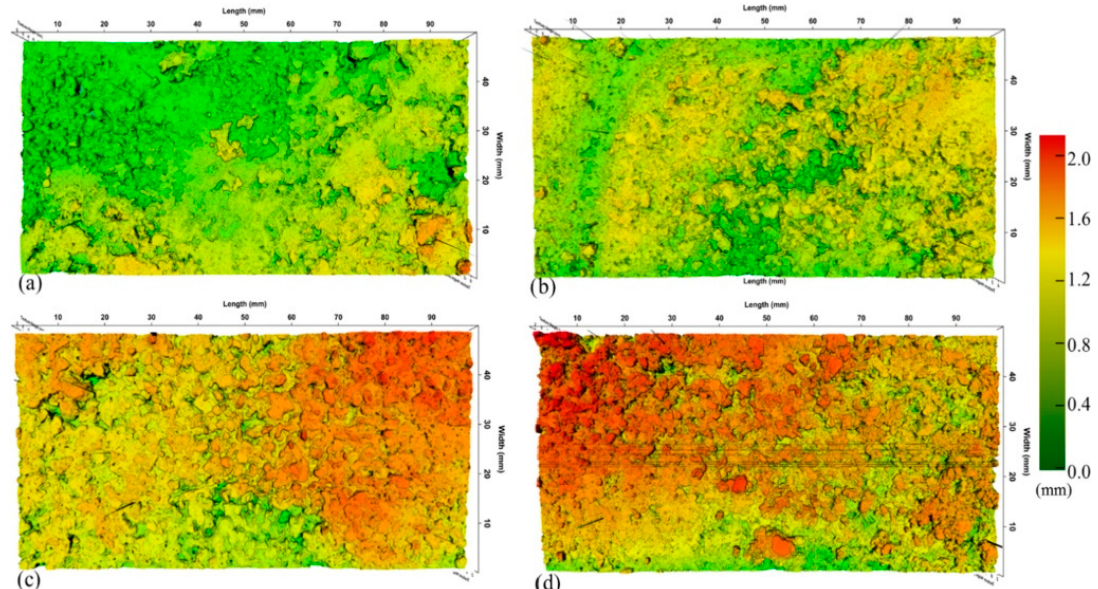
Figure 6. Three-dimensional surface models of different steel slag micro-surfacing, ( a ) basalt used as coarse and fine aggregates; ( b ) coarse basalt aggregates and fine steel slag; ( c ) coarse steel slag aggregates and fine basalt aggregates are; ( d ) steel slag used as coarse and fine aggregates.